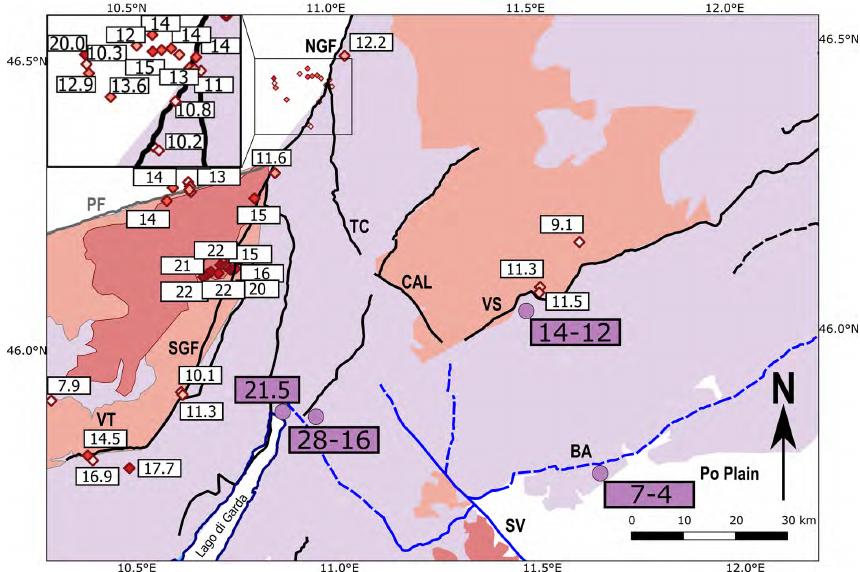
Figure 5. Compilation of stratigraphic and AFT age data in the eastern Southern Alps from Luciani and Silvestrini (1996), Martin et al. (1998), Castellarin and Cantelli (2000), Viola et al. (2001), Stipp et al. (2004), Pomella et al. (2011, 2012), and Heberer et al. (2016). Purple boxes mark biostratigraphic ages of deformed sediments (Castellarin et al., 1992). The inset map outlines the Adamello-Giudicarie area at the junction of the NGF and TC faults, with the locations of many tightly spaced age data. See Fig. 1 for fault abbreviations.